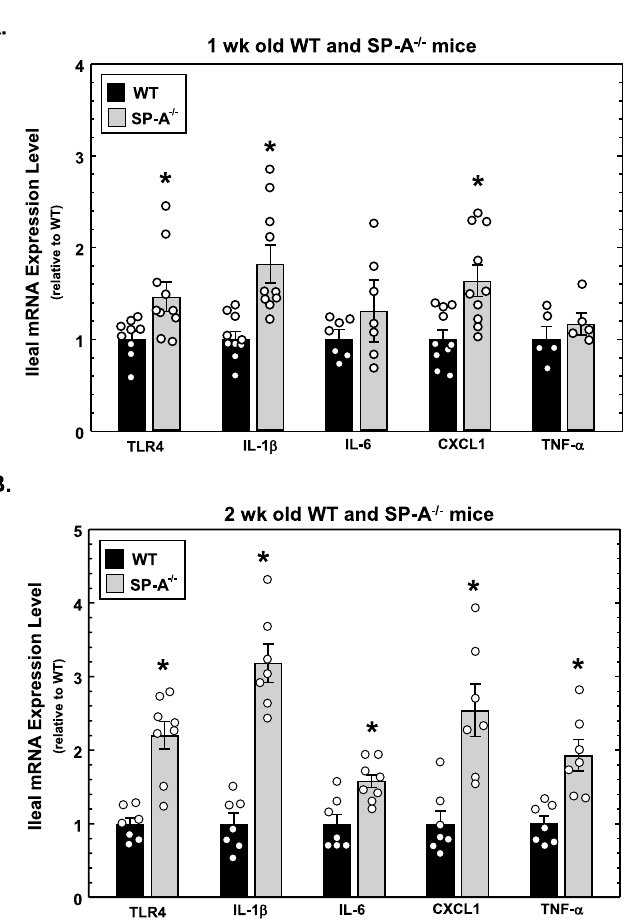
Figure 2. Expression of TLR4 mRNA and proinflammatory cytokine mRNA in the ileum of SP-A-deficient and wild type neonatal mice at 1 and 2 weeks of age. ( A ) Levels of mRNA isolated from the ileum of 1 wk old WT and SP-A −/− mice and assessed by quantitative real-time RT-PCR analysis. Shown are levels of expression relative to WT levels (set as 1). ( B ) Levels of mRNA isolated from the ileum of 2 weeks old WT and SP-A −/− mice and assessed by quantitative real-time RT-PCR analysis. Shown are levels of expression relative to WT levels (set as 1). * indicates P < 0.05, n ≥ 5 from ≥ 2 litters. Figure created using SigmaPlot, ver 14, www.systa tsoft